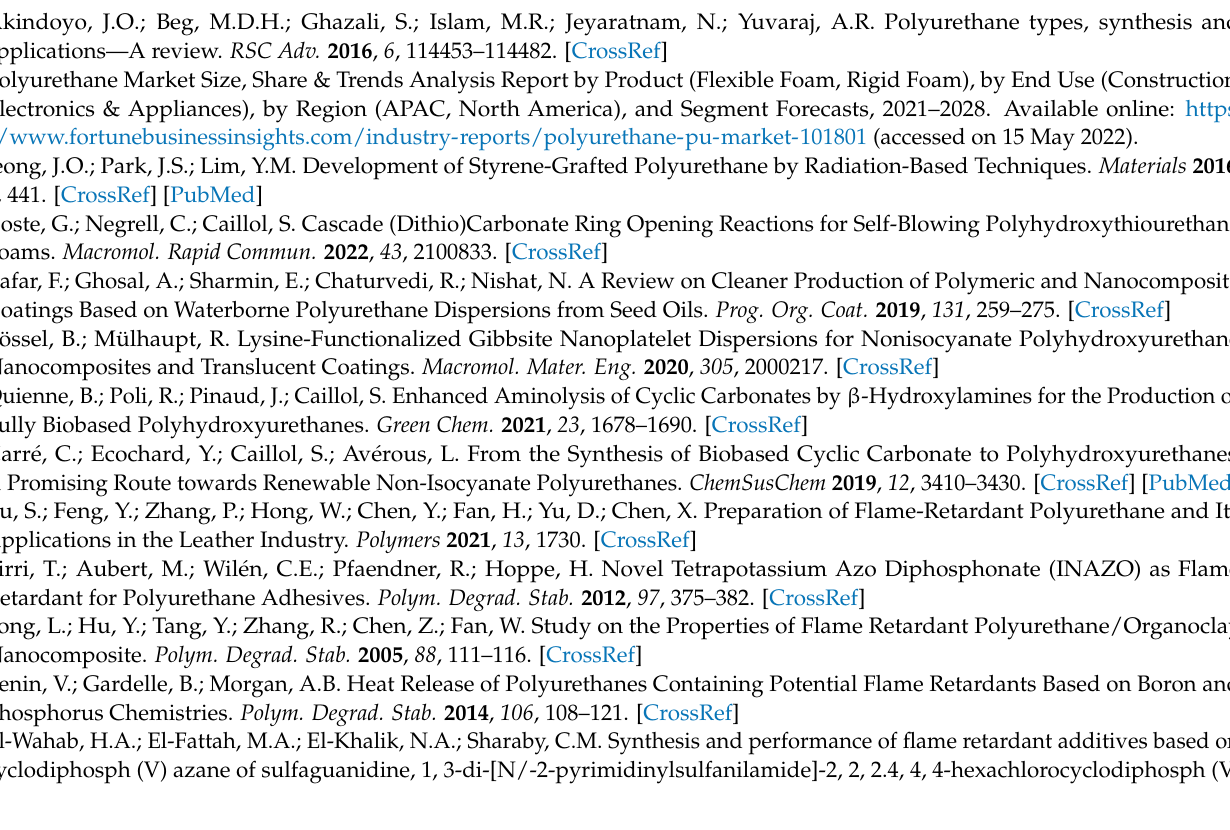
Figure S11: BPPO 1 H NMR; Figure S12: BPPO 31 P NMR; Figure S13: MBDA-BPPO 1 H NMR; Figure S14: MBDA-BPPO 31 P NMR; Figure S15: MBDAC-BPPO 1 H NMR; Figure S16: MBDAC-BPPO 31 P NMR; Figure S17: DEP 1 H NMR; Figure S18: DEP 31 P NMR; Figure S19: MBDA-DEP 1 H NMR; Figure S20: MBDA-DEP 31 P NMR; Figure S21: MBDAC-DEP 1 H NMR; Figure S22: MBDAC-DEP 31 P NMR; Figure S23: DPP 1 H NMR; Figure S24: DPP 31 P NMR; Figure S25: MBDA-DPP 1 H NMR; Figure S26: MBDA-DPP 31 P NMR; Figure S27: MBDAC-DPP 1 H NMR; Figure S28: MBDA-DPP 31 P NMR; Figure S29: DSC thermogram of the MBDAC-DOPO thermosets; Figure S30: DSC thermogram of the MBDAC-BPPO thermosets; Figure S31: DSC thermogram of the MBDAC-DEP thermosets; Figure S32: DSC thermogram of the MBDAC-DPP thermosets. Table S1: Foams formulations with DOPO; Table S2: Foams formulations with BPPO; Table S3: Foams formulations with DEP; Table